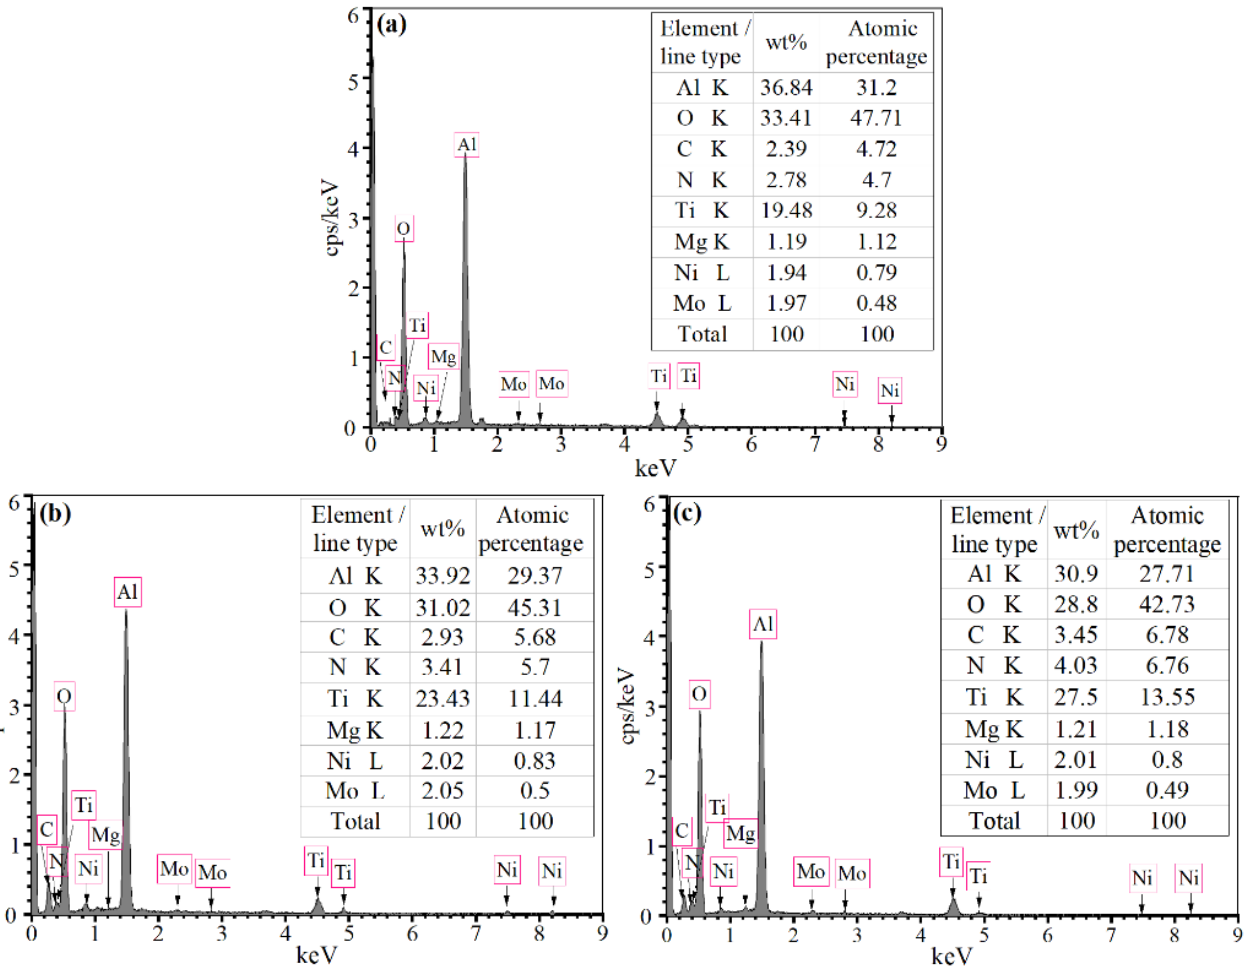
Figure 6. The EDS spectrum of St-x type Al 2 O 3 composite ceramics: ( a ) St1, ( b ) St2, ( c ) St3.